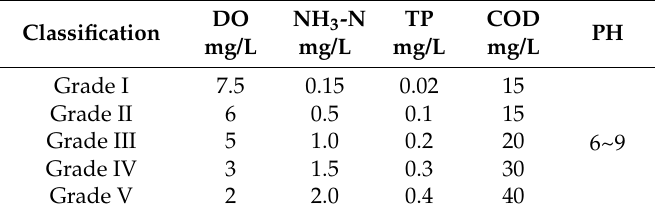
Table 2. China Environmental Quality Standards for Surface Water